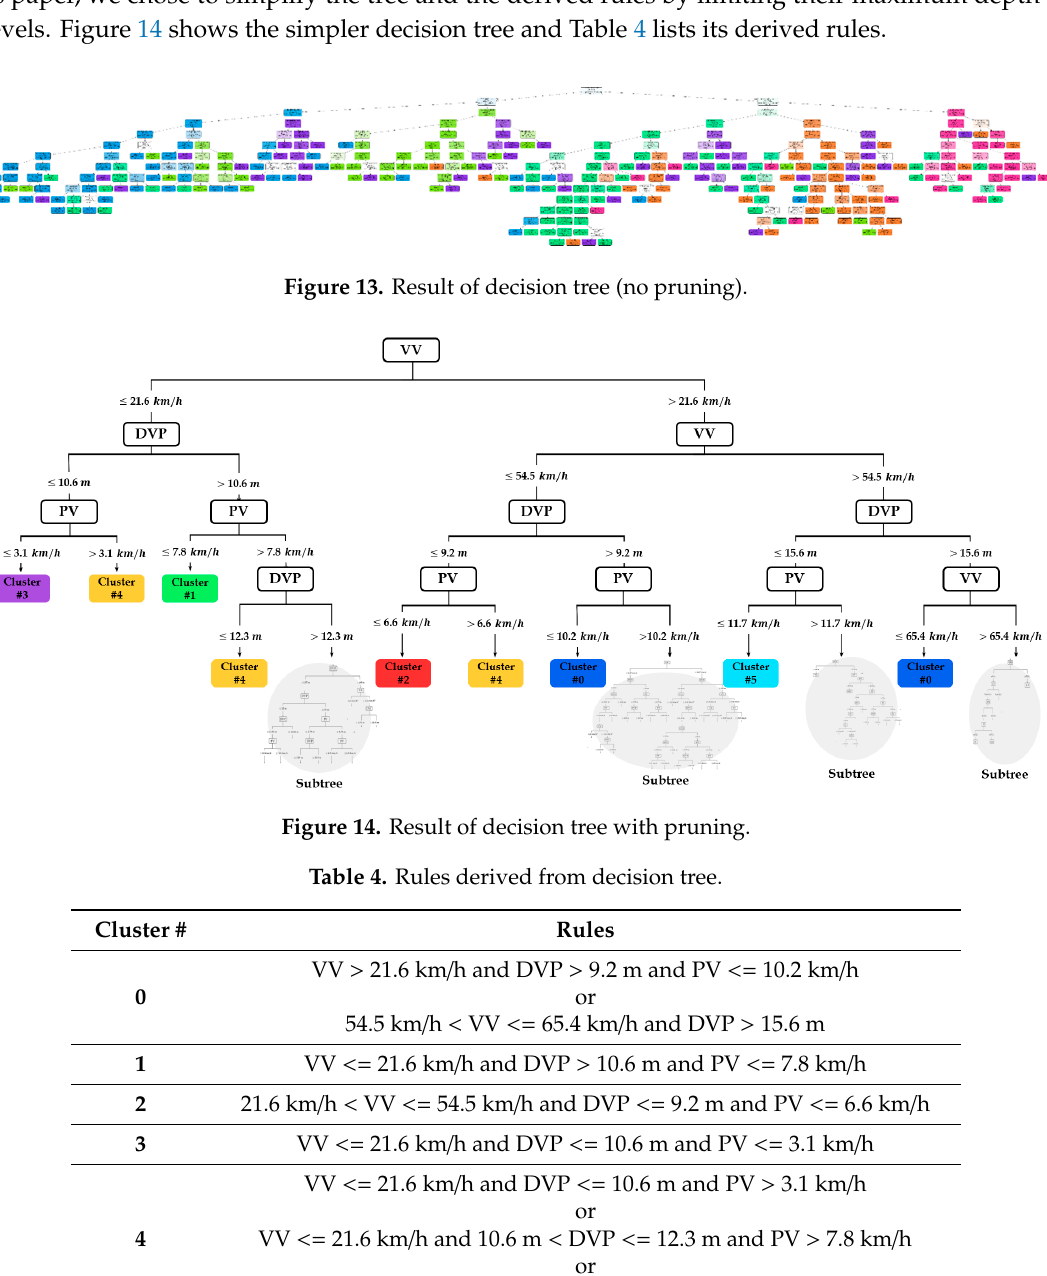
Table 4. Rules derived from decision tree.